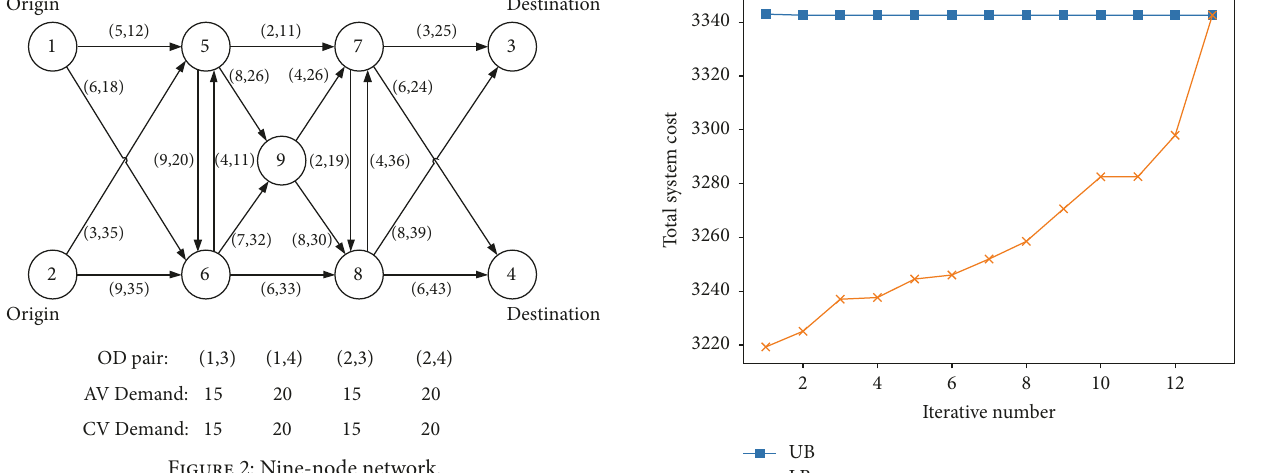
Figure 2: Nine-node network.